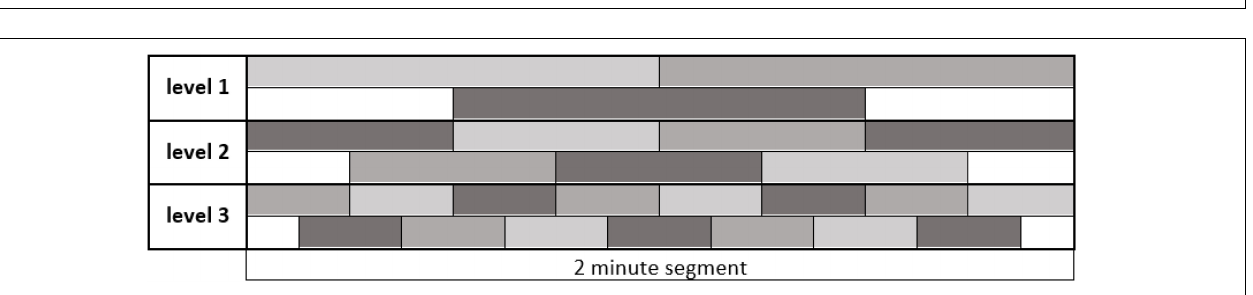
a distance between a shapelet and a segment. Segments and shapelets can be seen as two time series of different length (duration): a segment is always 2 min long, while shapelet length